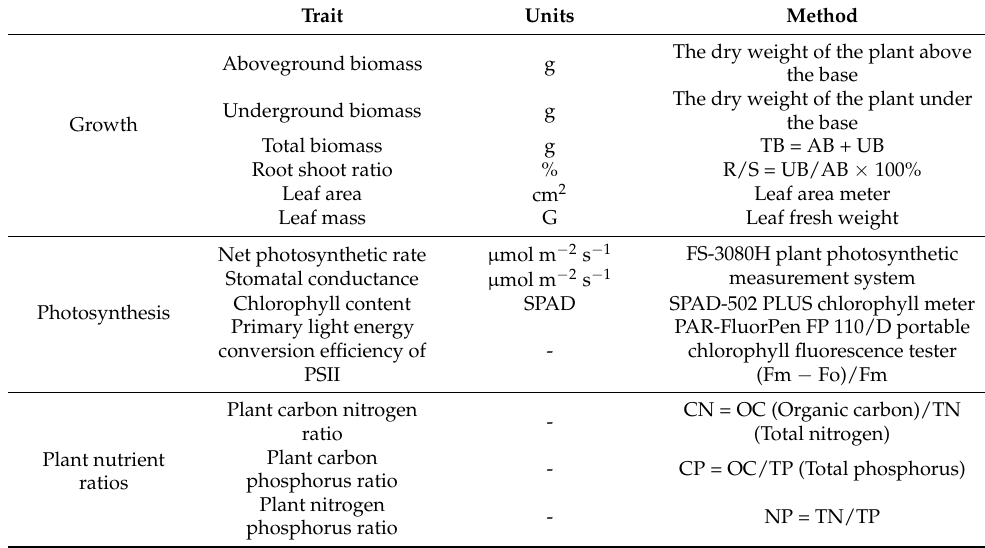
Table 4. Abbreviations, units, and methodology for the traits measured in this study.